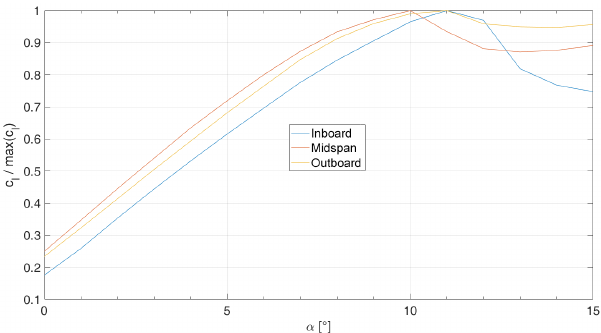
Figure 9. Lift polar curve of the inboard to midspan airfoils nor- malized to the respective maximum c l